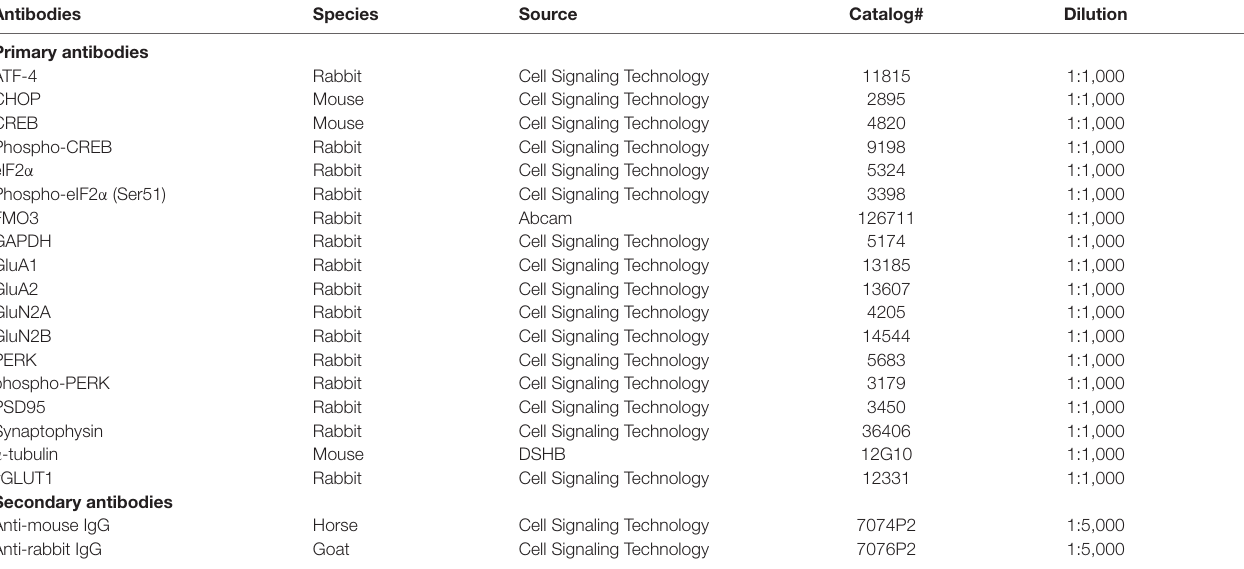
TABLE 1 | Summary of antibodies and working conditions used in the experiments. Antibodies Species Primary antibodies